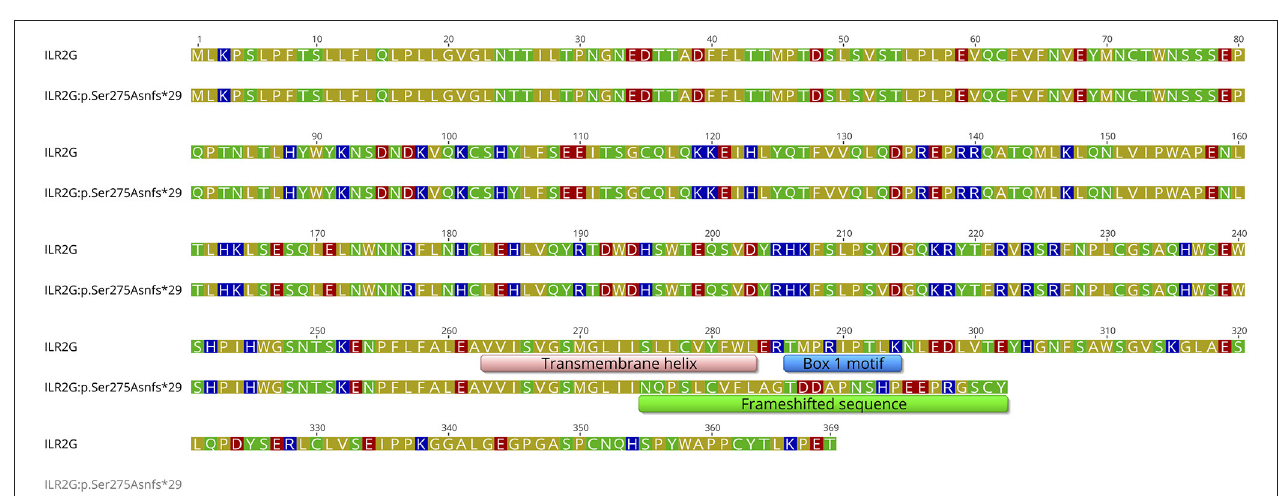
FIGURE 3 | Sections of routine stain from the soft tissue mass right distal ulna. (A) shows sheet of mononuclear cells of lymphocytes and histiocytes. (B) shows predominate lymphocytic infiltrate bone and skeletal muscle. (C) shows higher magnification of the right ulnar lesion routine stain section shows mononuclear cells predominantly of lymphocytes with scattered mitosis infiltrating skeletal muscle (skeletal muscle appears as eosinophilic striated tissue with peripheral nuclei at left side of the image). Most of the lymphocytes are B cell with CD20 positive immunohistochemical stain (D) , mixed with few scattered T lymphocytes highlighted with CD3 immunohistochemical stain (E) . Skin biopsy shows dermal inflammatory cells infiltrate, mainly of histiocytes with granulomatous inflammation (F) .